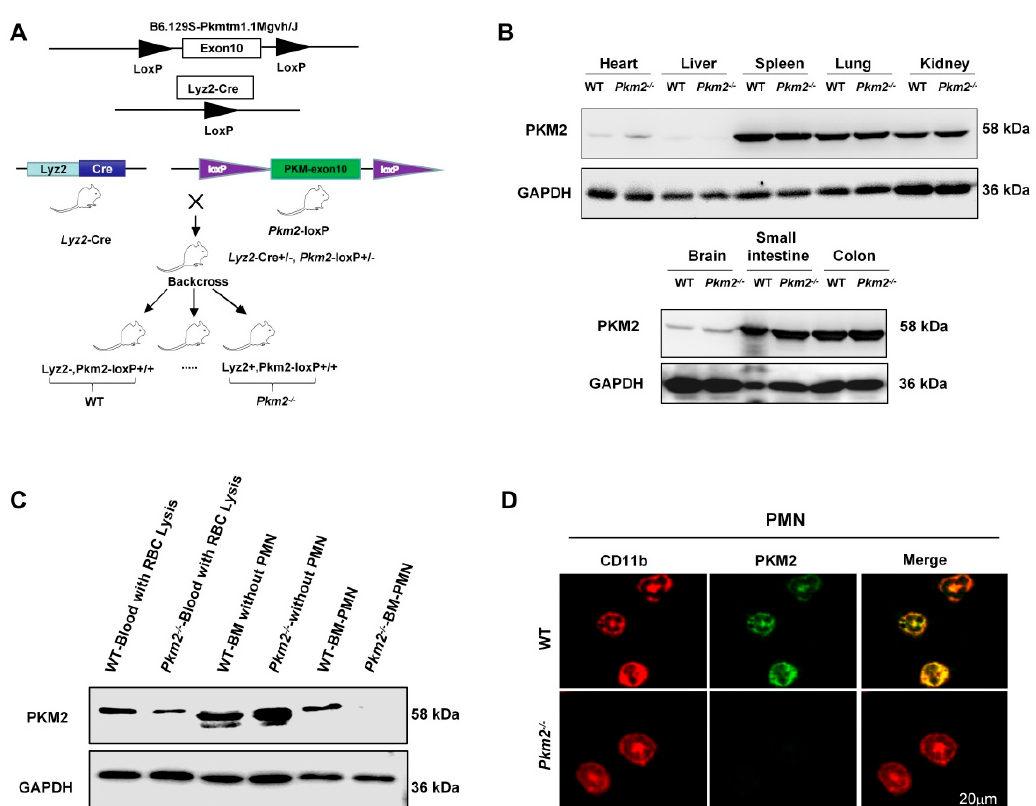
Figure 2. Identification of PMNs from myeloid-specific Pkm2 -/- mice. ( A ) Experimental design of the generation of PMN-specific Pkm2 knockout mice. ( B ) Validation of PMN-specific Pkm2 knockout in the non-myeloid tissue of mice using Western blotting. ( C ) Validation of PMN-specific Pkm2 knockout in the myeloid tissue of mice using Western blotting. ( D ) Validation of PMN-specific Pkm2 knockout in mice using immunofluorescence labeling.